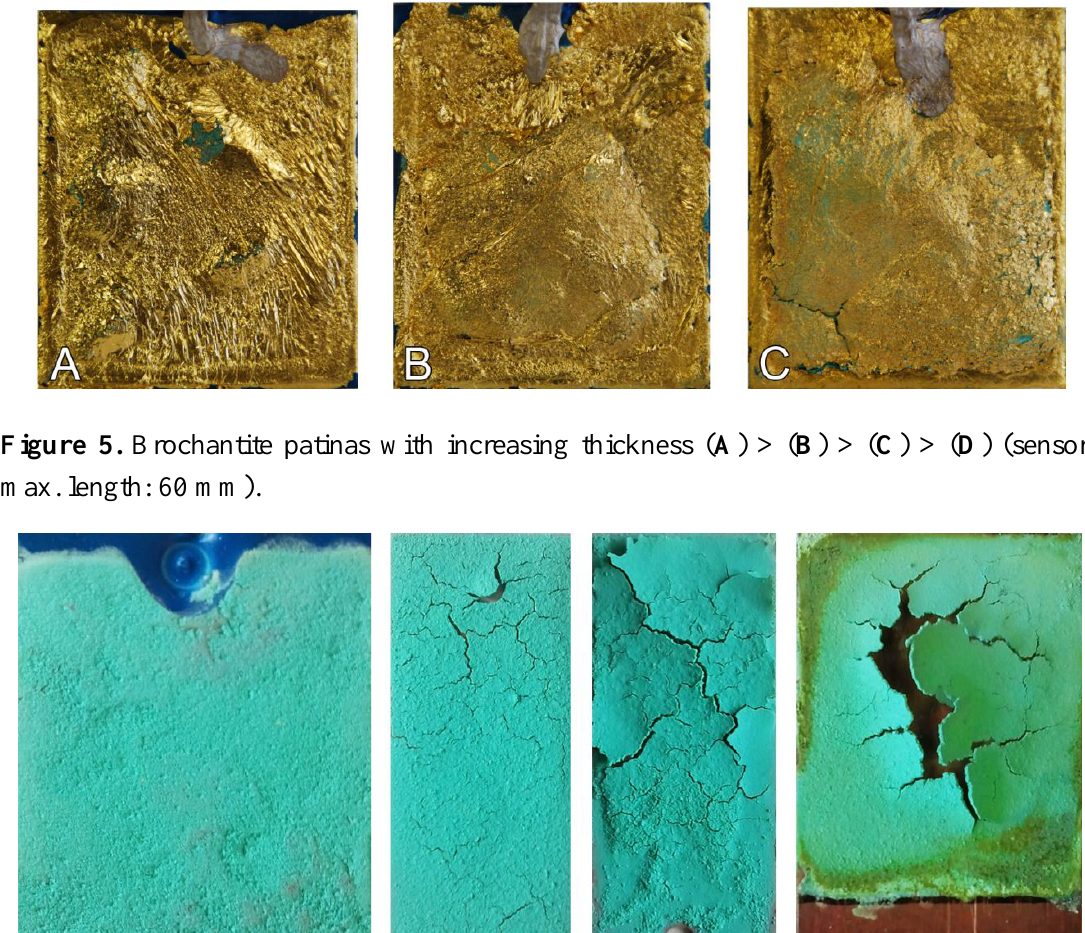
Figure 4. Photographic documentation of galvanic sensors with increasing thickness of the patina realized on copper substrate and with a S&C patina: single layer ( A ), double layer ( B ) and triple layer ( C ) (sensors dimensions: 60  50 mm).